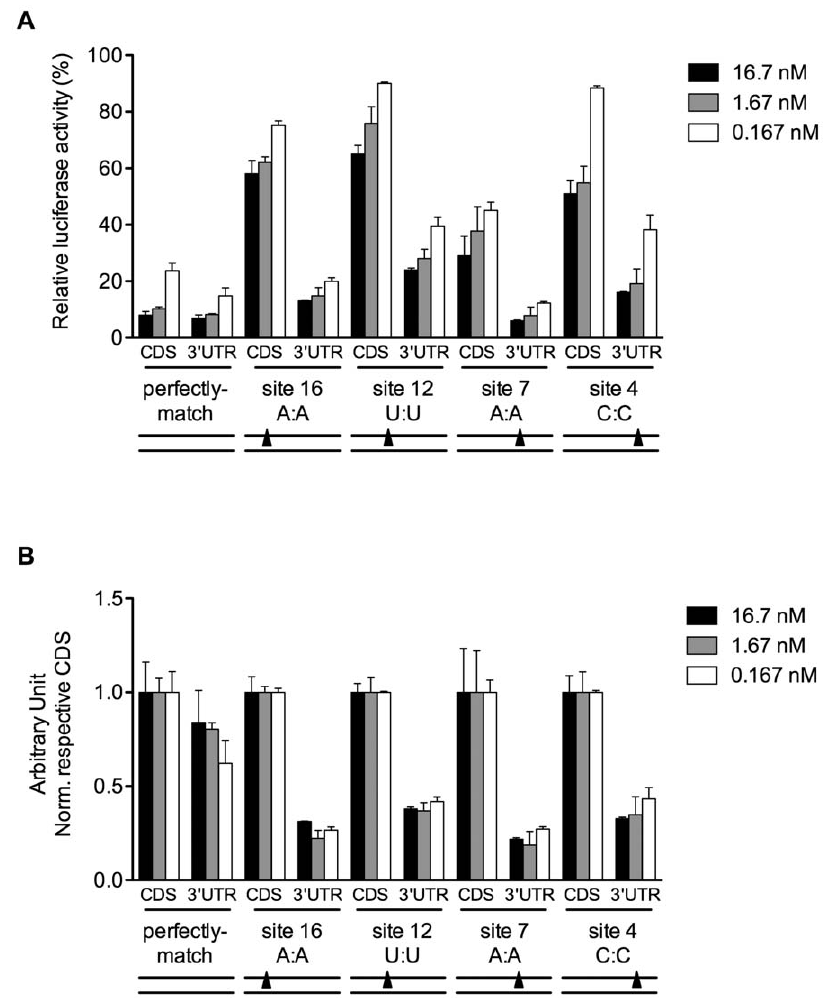
Figure 2. Elevated mismatch tolerance in 3 9 -UTR was independent of siRNA concentration. Silencing efficacies of siR-04 on matched and single-nucleotide mismatched targets in CDS versus 3 9 -UTR at the indicated positions (4C, 7A,12U, 16A) were shown as (A) original data and (B) normalized data, by using varying siRNA concentrations from 0.167 to 16.7 nM. The normalized data were calculated by normalizing each original silencing efficacy of siRNA towards 3 9 -UTR site to that towards CDS site. The target site location and siRNA:mRNA match pattern were given under the x-axis. The y-axis represented siRNA silencing activities. The lower bars indicated siRNA had stronger silencing activities. Below the diagram was a simple graph, double lines indicated siRNA(down):mRNA(up) duplex, the solid triangle indicated the position of mismatch within the target site. Error bars represented SD. Data were average values of assays in triplicates, and all experiments were repeated at least twice.